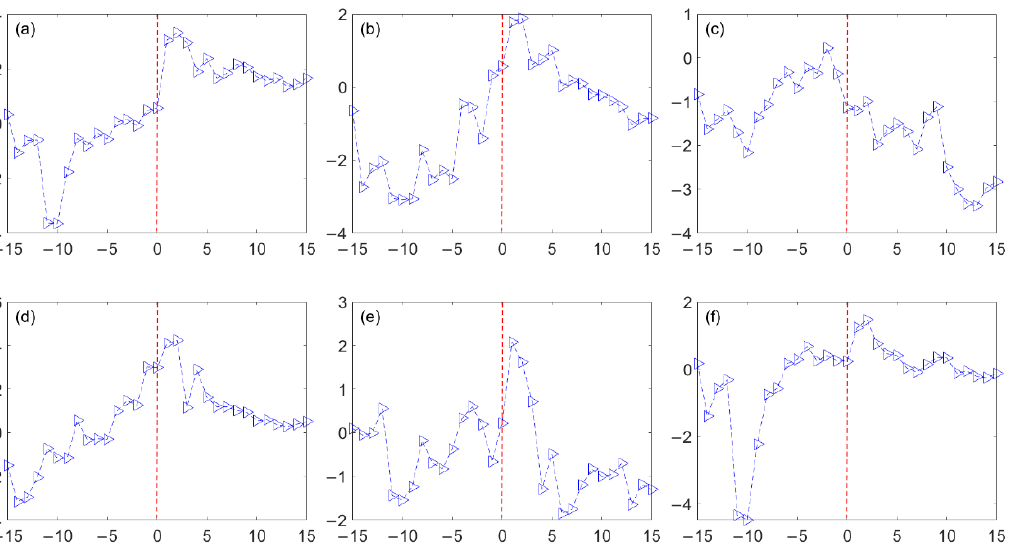
Figure 7. Strike of the event of the Sino–U.S. trade war B1 on the outlier of net spillover effect: ( a – f ) show the outlier of net spillover between the carbon market (CT) and oil (OPI), electricity (PI), steel (SI), chemicals (CI), non-ferrous metals (NFMI), and banking (BI) sectors, respectively.